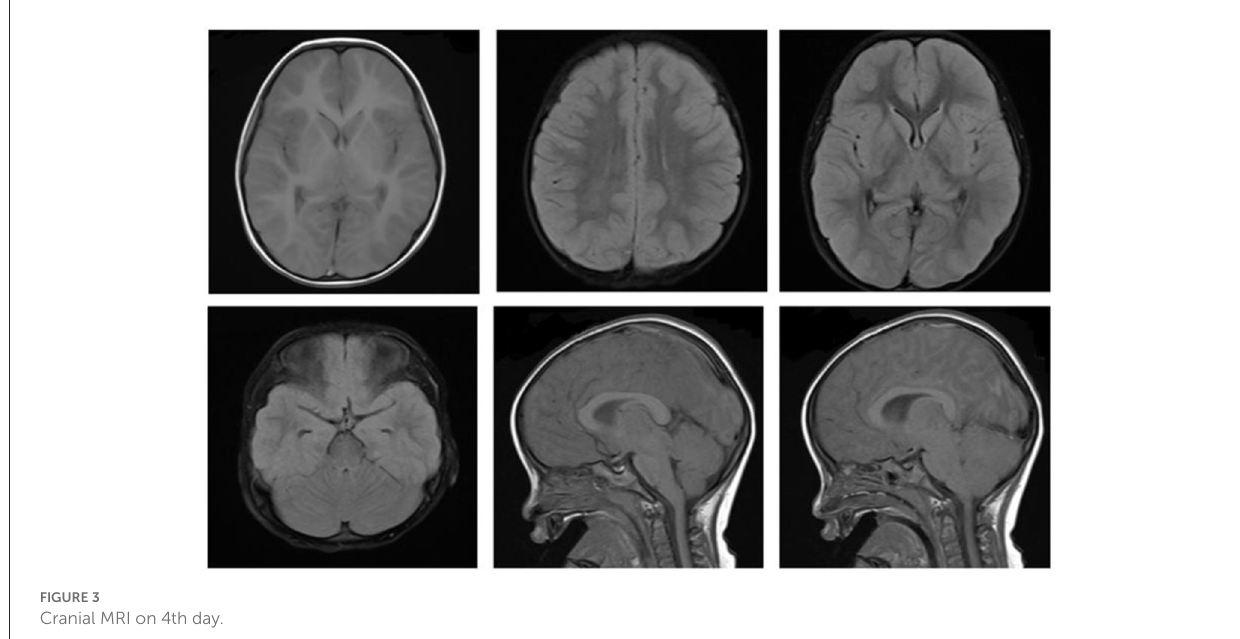
FIGURE3 Cranial MRI on 4th day.